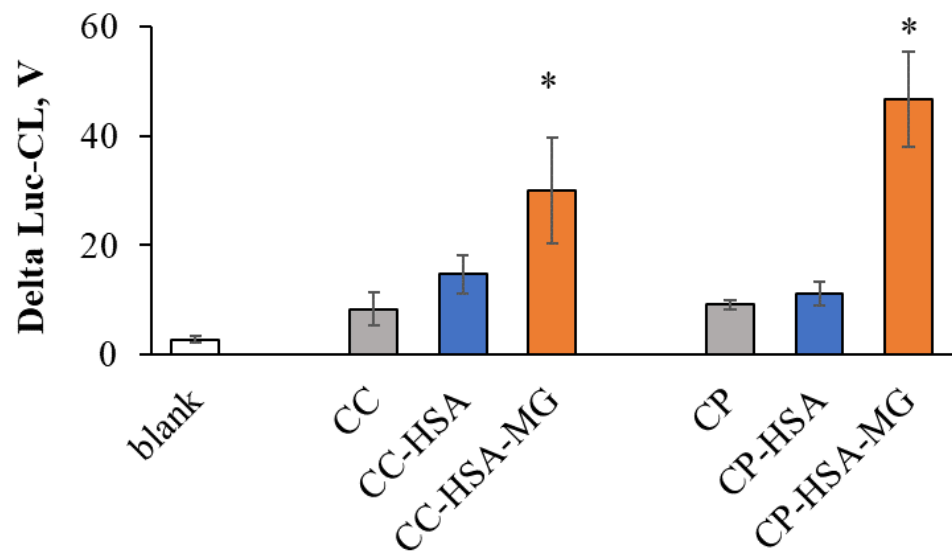
Figure 7. Scanning electron image of typical vaterite microparticle ( a ) and a microparticle composed of calcium phosphate nanowires ( b ).